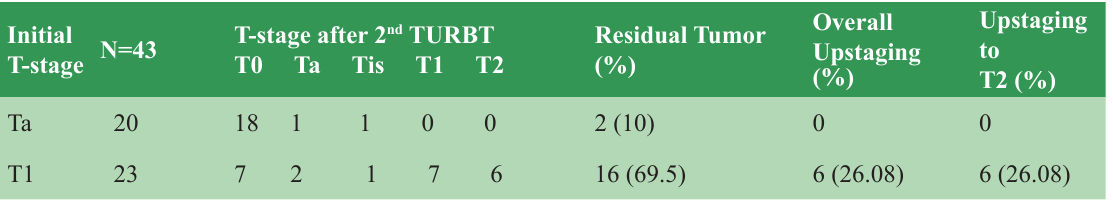
Table 1: Histopathology after after second